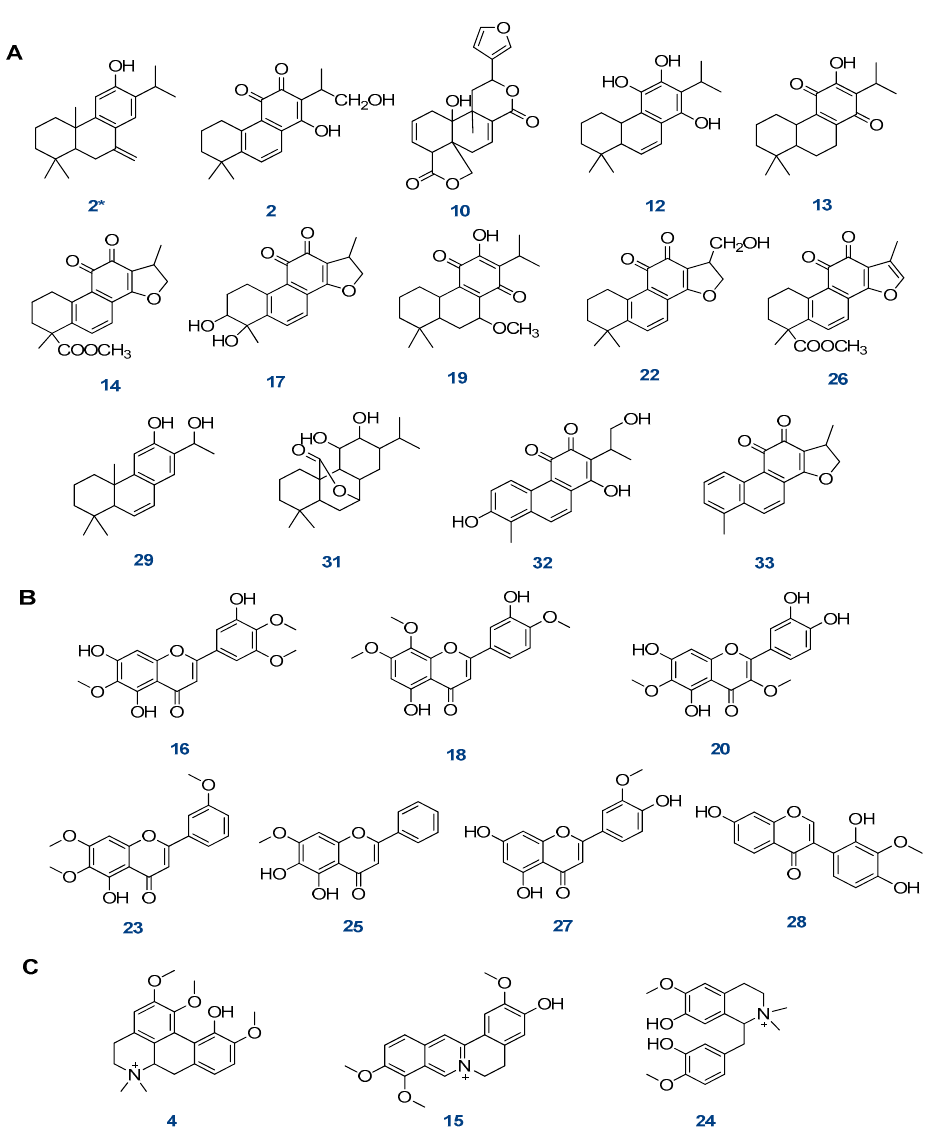
Figure 3. The structure of the tentatively identified compounds in the dichloromethane fraction of S. hispanica L. aerial parts. ( A ) Diterpenes, ( B ) flavonoids, ( C ) alkaloids. Compound 31 (R t , 17.04 min) produced both a precursor ion at m / z 329 [M-H] − as well as a fragment ion at m / z 285 [(M-H-CO 2 )] − . This fragmentation is typical for carnosol [45]. Compound 32 (R t , 25.32 min) showed a precursor ion at m / z 313 [M+H] + , and the presence of a fragment ion at m / z 269 [(M+H-CO 2 )] + is characteristic of hydroxy tanshinone VI [33]. Compound 33 (R t , 27.12 min) exhibited a precursor ion at m / z 279 [M+H] + and a fragment ion at m / z 261 [(M+H-H 2 O)] + , and it was identified as 15,16-dihydrotanshinone I [35].